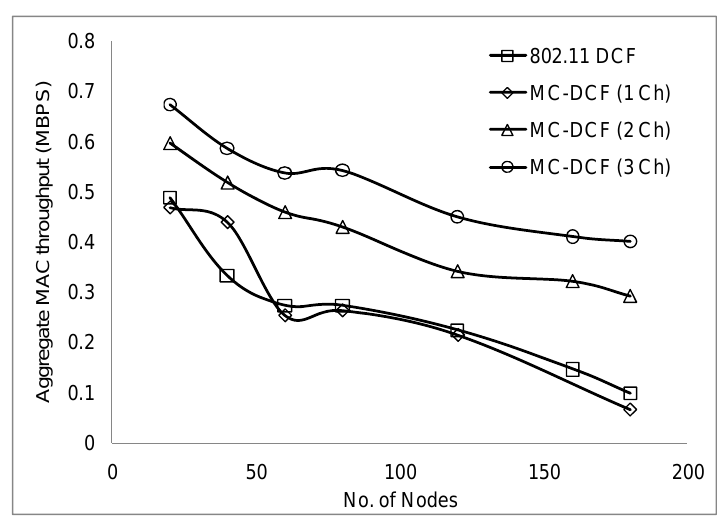
Figure 14. Throughput impact on node density.